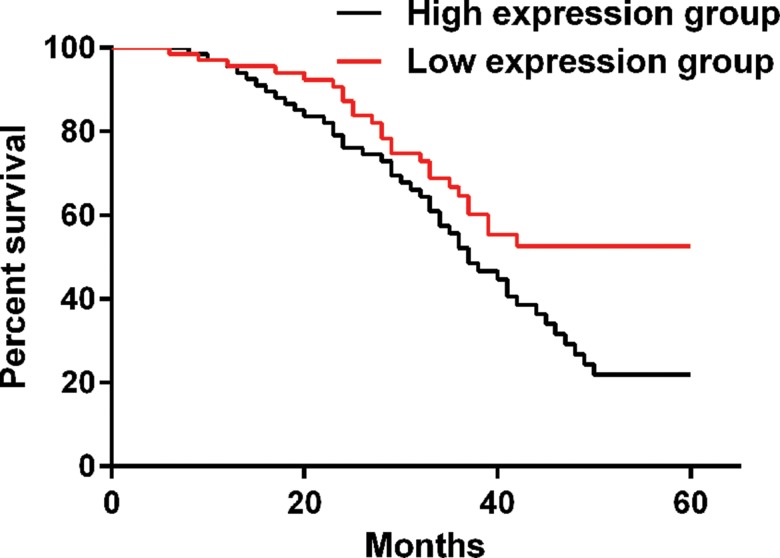
Kaplan-Meier curve. The Kaplan-Meier curve shows that the 5-year patient survival rate was 64.2% in the low IL-10 group and 42.8% in the high IL-10 group. A significant difference was observed between the two groups (p=0.012).